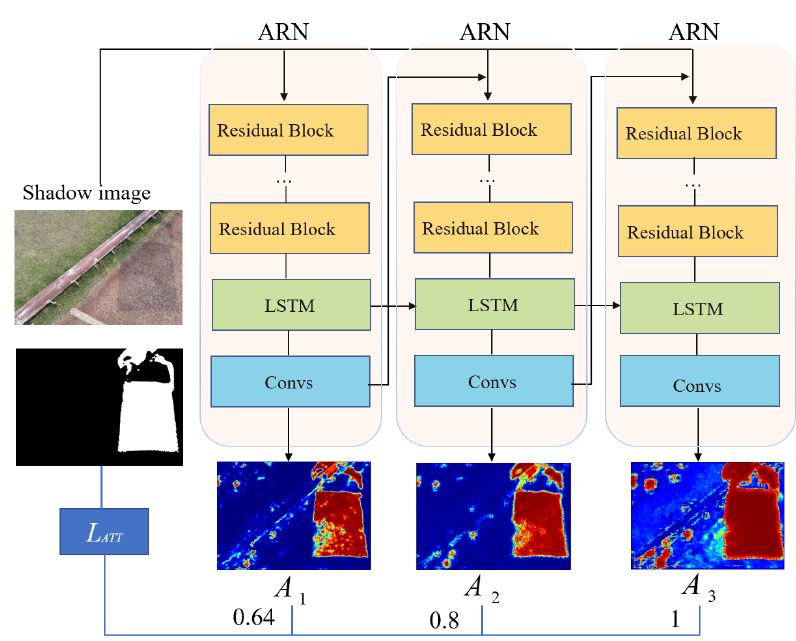
Figure 4. The architecture of our attentive-recurrent network. The input is a shadowed image, and the output of each ARN is fed to the next ARN. A 1, A 2, and A 3 are the attention maps of each ARN. The color means the attention weight of different